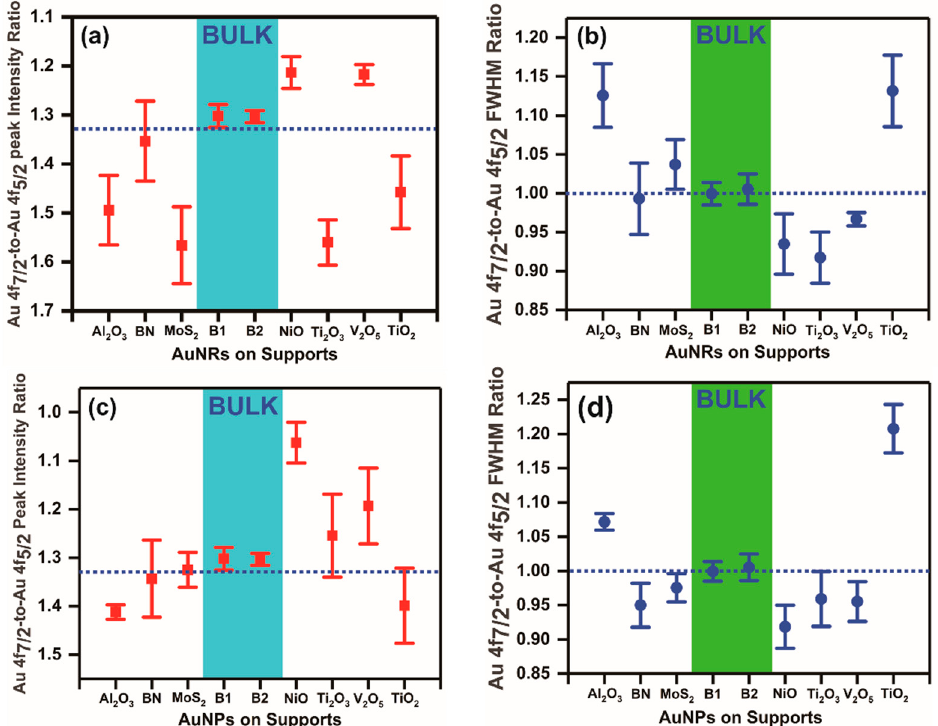
Figure 5. The Au 4f 7/2 -to-Au 4f 5/2 peak intensity ( a , c ) and linewidth ratios ( b , d ) in the supported gold nanoparticles and gold nanorods. A comparison is made in all cases against bulk gold samples, B1 and B2, in all cases. Both the Au 4f 7/2 -to-Au 4f 5/2 peak intensity and linewidth ratios deviated largely from bulk standard values.